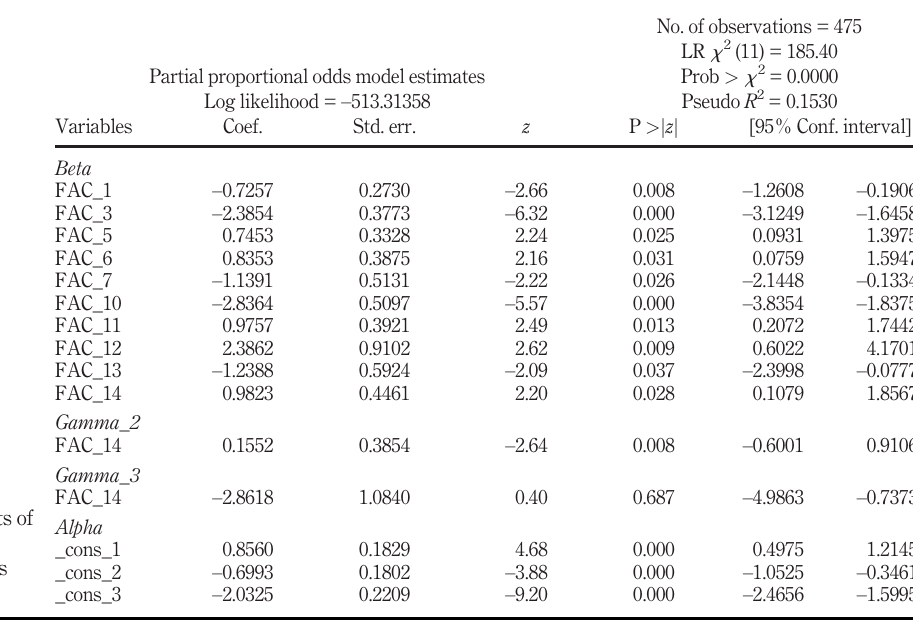
Table 4. Estimation results of